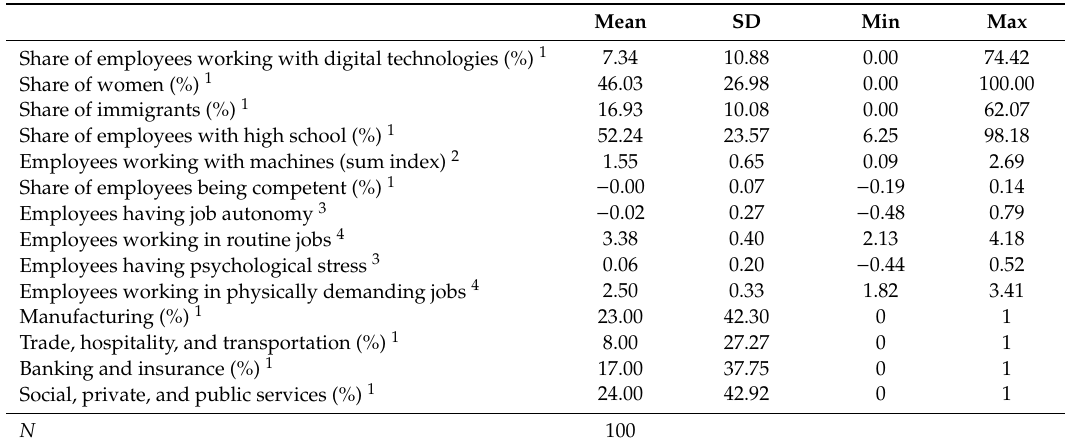
Table 2. Description of organizational characteristics for the analysis sample of large German workplaces. Mean SD Min